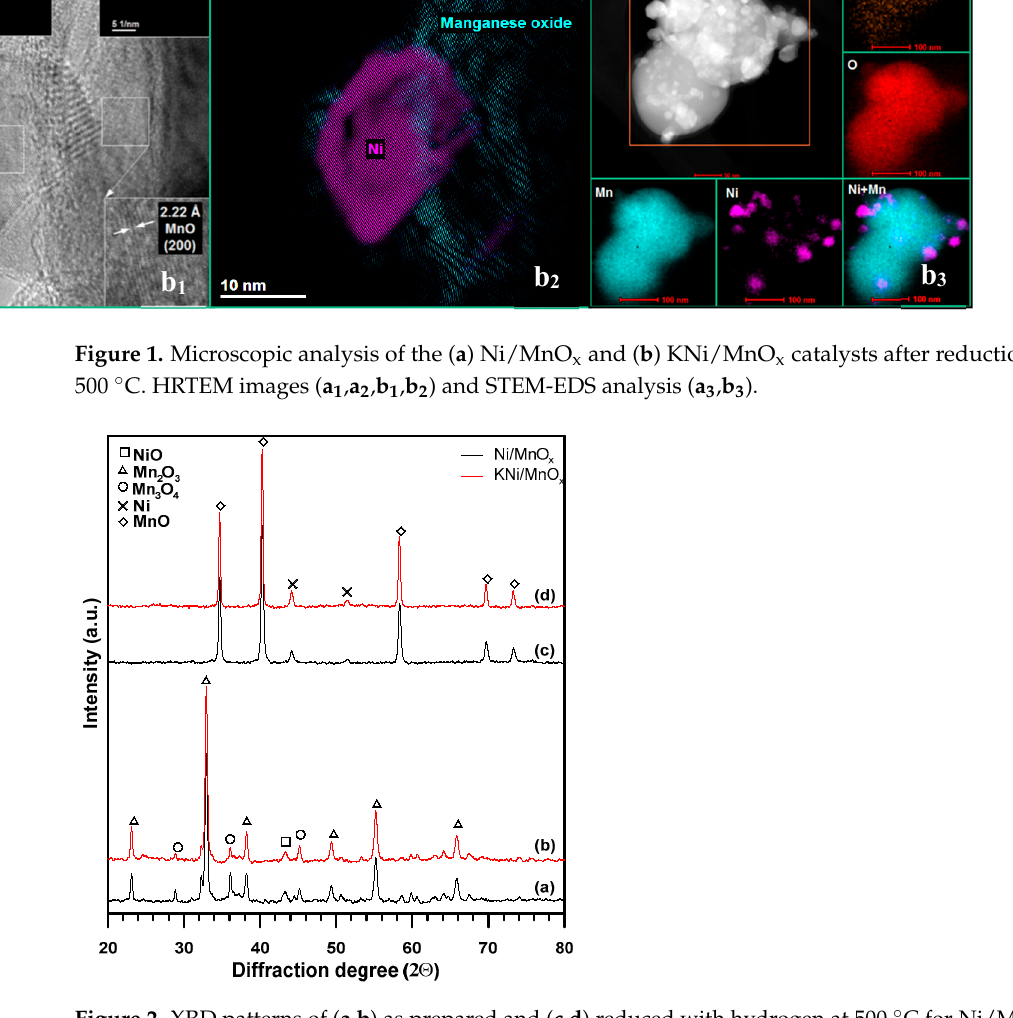
Figure 2. XRD patterns of ( a , b ) as prepared and ( c , d ) reduced with hydrogen at 500 °C for Ni/MnO x and KNi/MnO x catalysts.